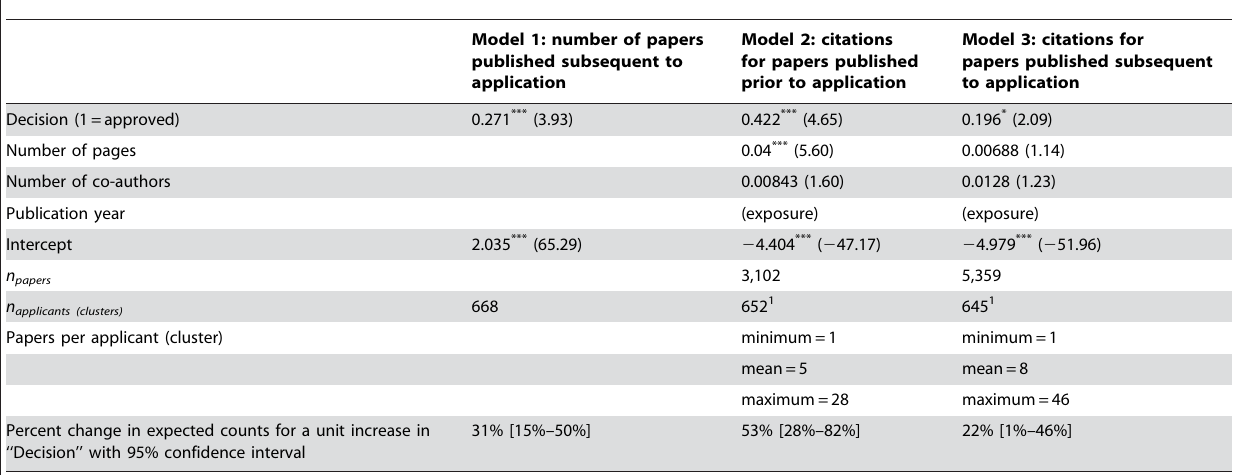
Table 2. (Zero-truncated) negative binomial regression models predicting (1) number of papers published subsequent to application, (2) citations for papers published prior to application and (3) citations for papers published subsequent to application (applicants for the LTF